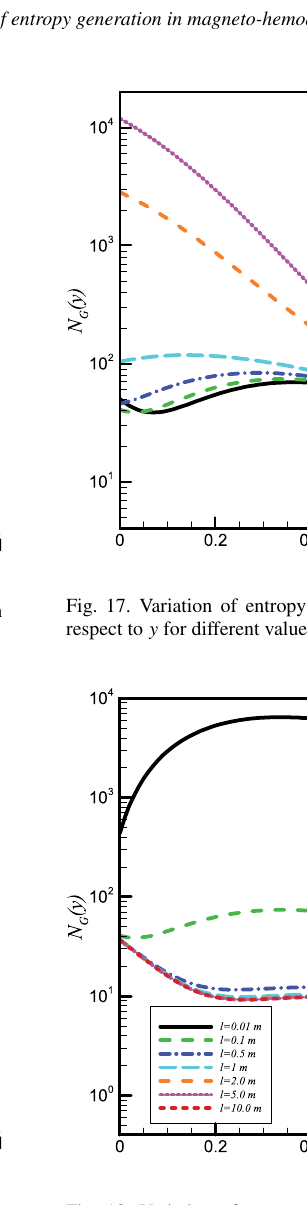
Fig. 18. Variation of entropy generation parameter, N G ( y ) , with respect to y for different values of suspension